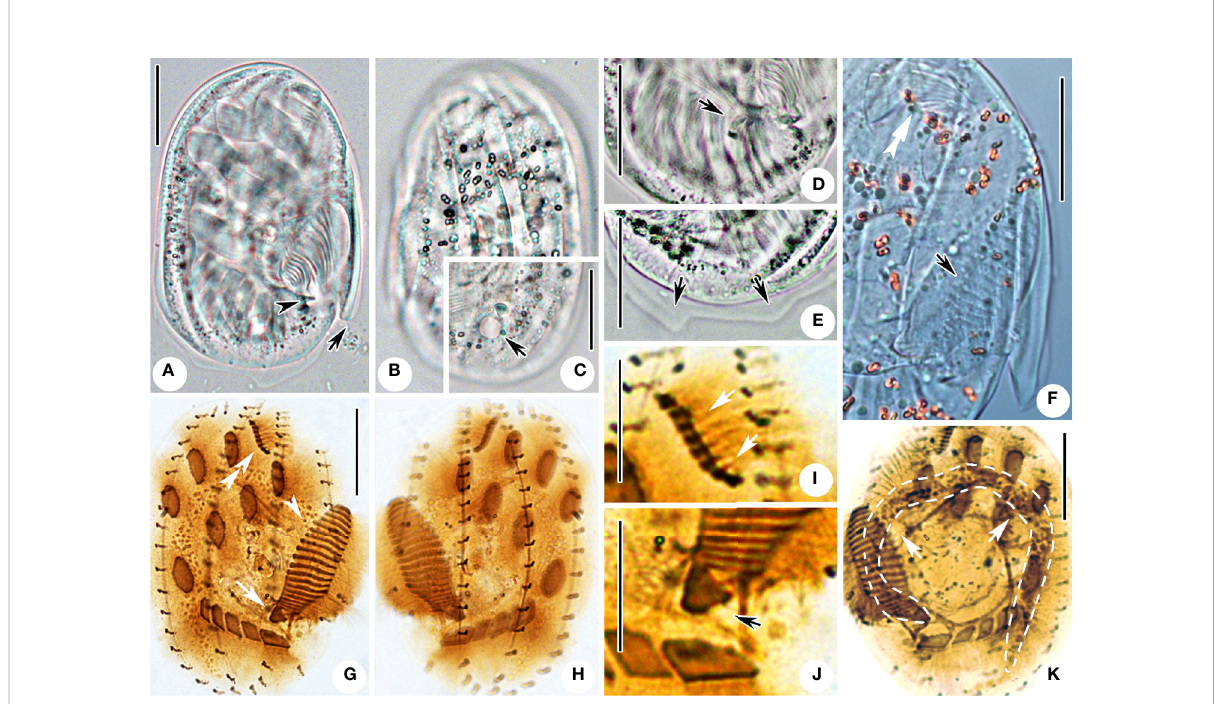
FIGURE 3 Microphotographs of Aspidisca spina sp. n. in life (A – F) and after protargol impregnation (G – K) . (A) Ventral view of a representative individual; arrow marks the peristomial spur, and arrowhead marks the bulge. (B) Dorsal view, showing the ridges. (C) Dorsal view; arrow indicates the contractile vacuole. (D) Ventral view, arrow points to the leftmost transverse cirri. (E) Dorsal view, showing the protrusions on the posterior cell margin (arrows). (F) Ventral view; double arrowheads point to AZM1, and arrow points to AZM2. (G, H) Infraciliature of ventral and dorsal sides of the same specimen; double arrowheads point to AZM1, arrowhead points to AZM2, and arrow points to PM. (I) Ventral view, arrows showing the AZM1. (J) Ventral view of the posterior part of AZM2; arrow marks the paroral membrane. (K) Dorsal view, arrows showing the macronucleus. Scale bars: 20 µm (A – H, K) , 10 µm (I, J)